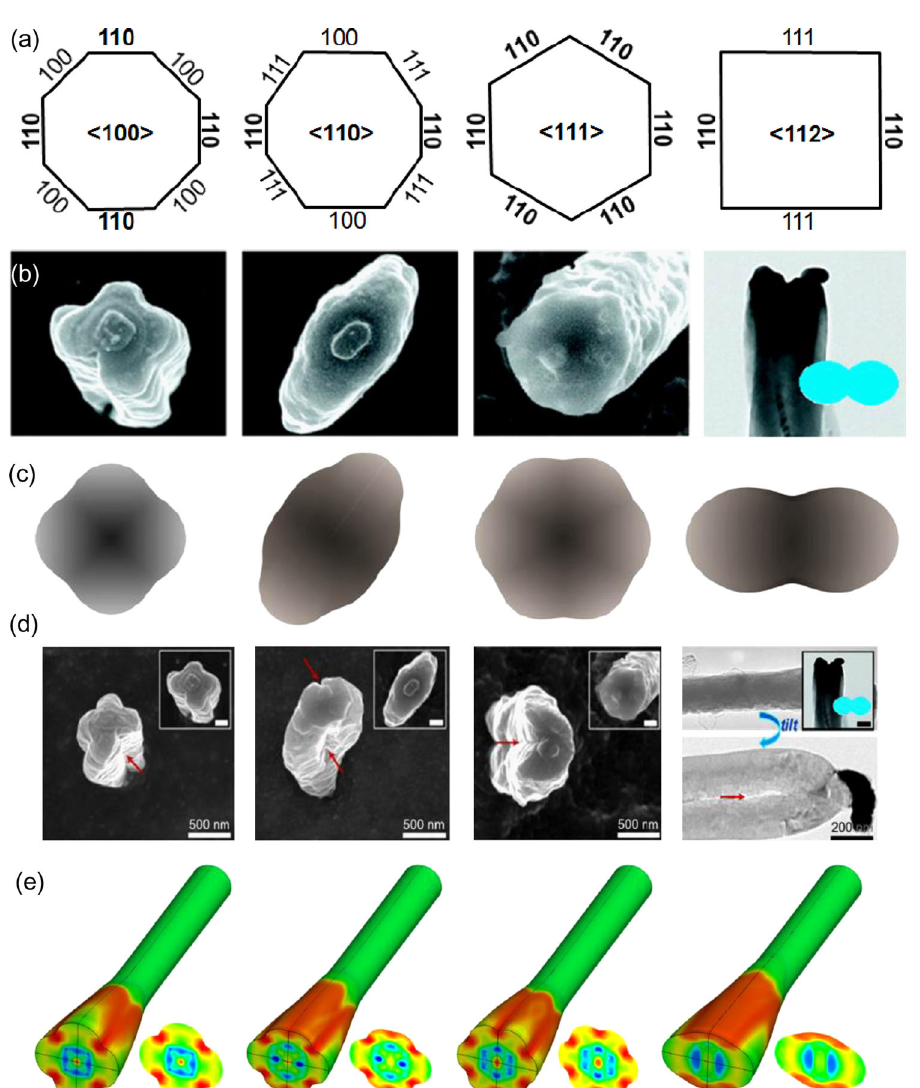
Fig. 3 Lithiation-induced anisotropic swelling and fracture in c -Si. a Four c -SiNWs with different crystallographic orientations. Indices in the center represent the axial orientation, while those on the sides the orientations of the facets. b SEM 82 (the fi rst three columns) and TEM 8 (the last column) images of a fully lithiated c -SiNWs, displaying different cross-sectional morphologies with clear swelling anisotropy. c Anisotropic cross-sectional morphologies of lithiated c -SiNWs corresponding to the orientations shown in ( a ), predicted by the front-tracking fi nite element modeling. 9, 67 d SEM 82 (the fi rst three columns) and TEM 8 (the last column) images showing the crack nucleation sites (marked by red arrows ) in the lithiated c -SiNWs of four different orientations ( a ). e Stress concentration locations ( red spots ) predicted by 3D front-tracking fi nite element modeling 63 coincide with the experimentally observed crack nucleation